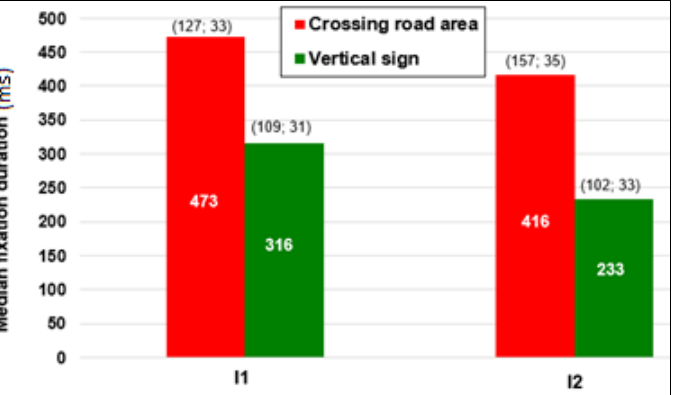
Figure 7. Median fixation duration at crossing road area (pavement) and at vertical signs (portal overhead bicycle/pedestrian crossing sign for “I1” and “ Yield here to pedestrians and cyclists ” vertical sign for “I2”) (standard deviation and number of observations are reported in brackets).